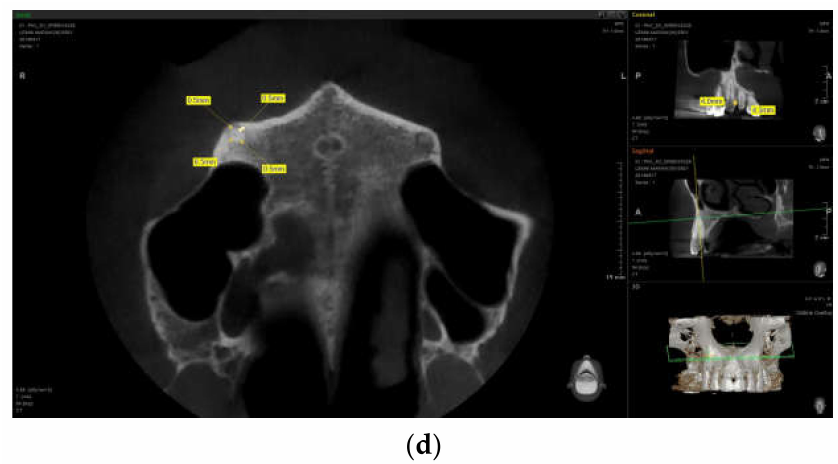
Figure 1. Measurements of periodontal ligament space on cone beam computed tomography (CBCT): ( a ) clinical attachment level (CAL) and apical PDL space measurements; ( b ) 8-point cervical third measurements; ( c ) 4-point middle third measurements; and ( d ) 4-point apical third measurements.